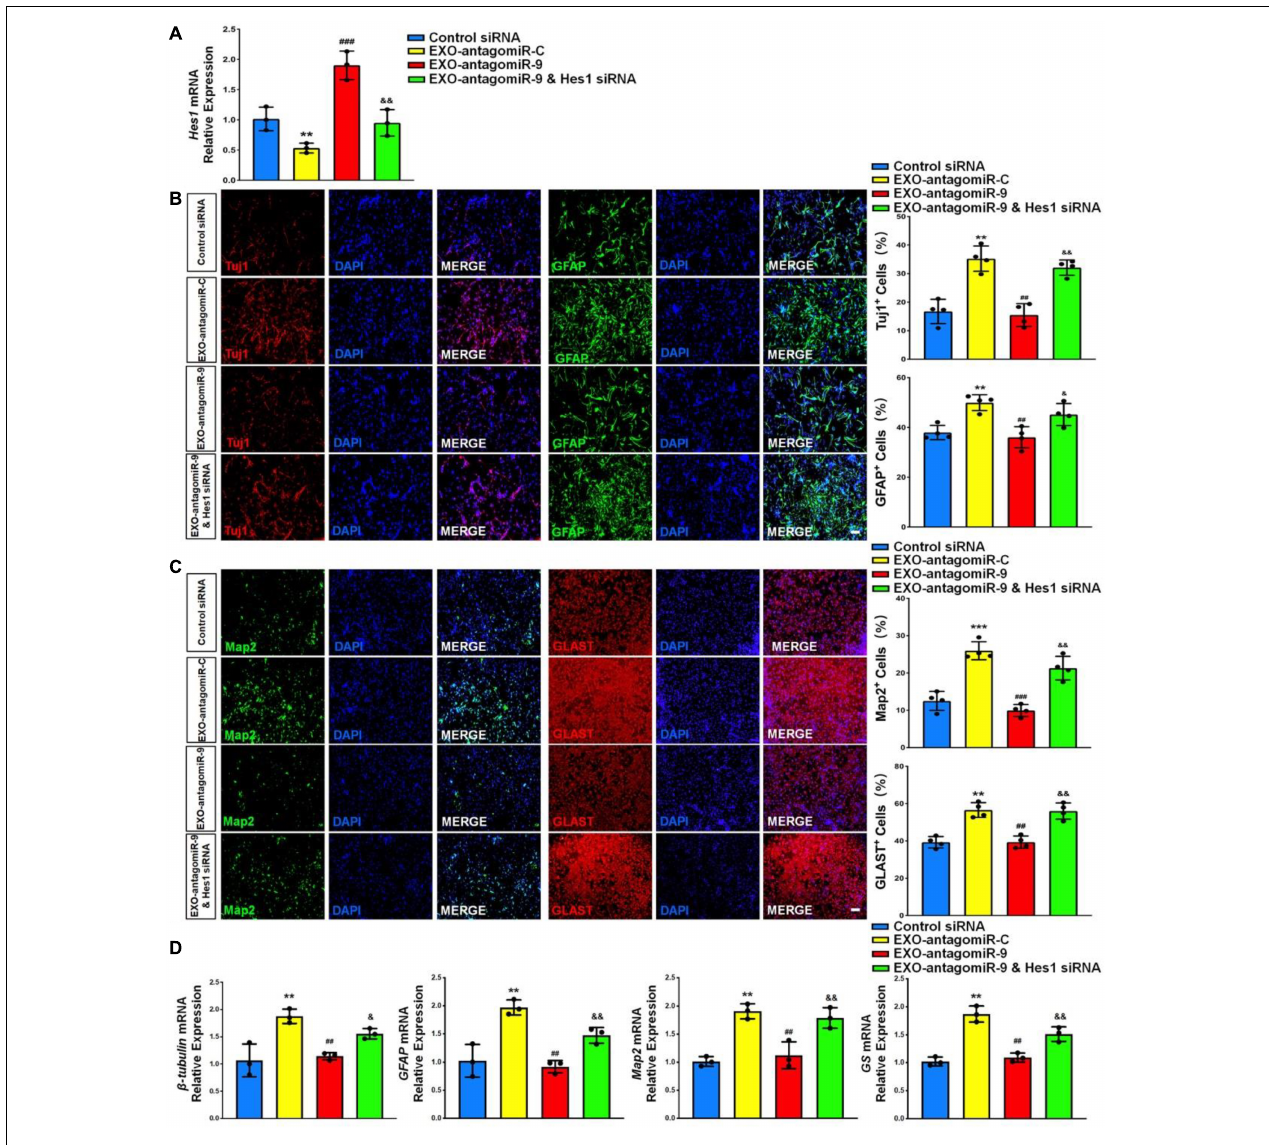
FIGURE 9 | Exosomal miR-9 regulates NSC differentiation via repressing Hes1 . (A) NSCs were divided into four groups for scrambled siRNA transfection, EXO-antogomiR-C co-culture, EXO-antogomiR-9 co-culture, or EXO-antogomiR-9 co-culture with Hes1 siRNA transfection. NSCs were then cultured in differentiation conditions for 6 days. The expression levels of Hes1 in each group were determined by RT-qPCR. (B) Representative images of pre-mature cell markers (Tuj1 and GFAP) staining were shown. Proportions of cells exhibiting immunoreactivities of pre-mature cell markers (Tuj1 + and GFAP + ) were determined (in the right panel). (C) Representative images of matured cell markers (Map2 and Glast) staining were shown. Proportions of cells exhibiting immunoreactivities of pre-mature cell markers (Map2 + and Glast + ) were determined (in the right panel). (D) The expression levels of transcripts corresponding to pre-mature cell markers ( β III-tubulin and GFAP ) and matured cell markers ( Map2 and GS ) were determined by RT-qPCR analysis. Data were represented as mean ± SE from three independent experiments. *, **, and *** denote p < 0.05, p < 0.01, and p < 0.001 in comparison to control, respectively. #, ##, and ### denote p < 0.05, p < 0.01, and p < 0.001 in comparison to EXO-antagomiR-C group, respectively. & and && denote p < 0.05 and p < 0.01 in comparison to EXO-antagomiR-9 group, respectively. Scale bar 100 µ m in panel (C,D)